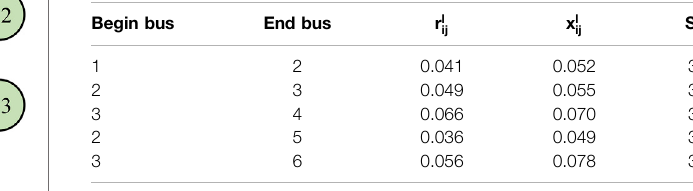
TABLE 2 | Line data (in p.u.).